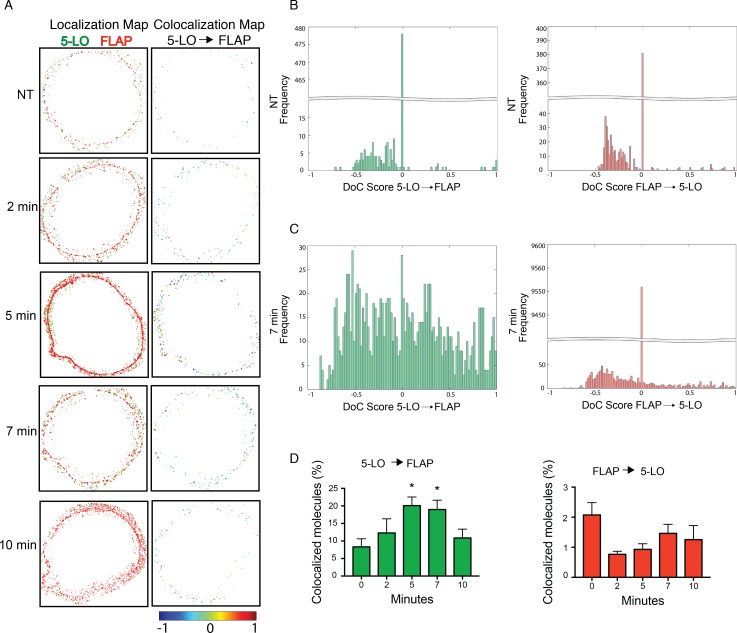
5-LO and FLAP colocalize on the nuclear envelope by two-color dSTORM.RBL-2H3 cells were primed with anti-TNP IgE then activated with TNP-BSA for 2, 5, 7 and 10 min, or left not treated (NT). Localization data was collected by two-color dSTORM and analyzed with ClusDoC. Data shown is from the representative cells shown in Fig 2. (A) Localization maps for 5-LO (green) and FLAP (red) (left panels) and colocalization maps for 5-LO relative to FLAP. 5-LO molecules are color-coded according to their degree of colocalization (DoC) scores (right panels, score bar at the bottom). (B,C) Histograms of DoC scores of all molecules for 5-LO (green) and FLAP (red) from representative cells at (B) 0 and (C) 7 min. (D) Percent colocalization of 5-LO molecules with FLAP from all ROIs (left panel; green) and percent colocalization of FLAP molecules with 5-LO from all ROIs (right panel; red). Statistical significance was assessed by Kolmogorov-Smirnov test, with significance indicated by *p < 0.05. Bars show mean ± SEM from 4 to 21 cells over 3 separate experiments.